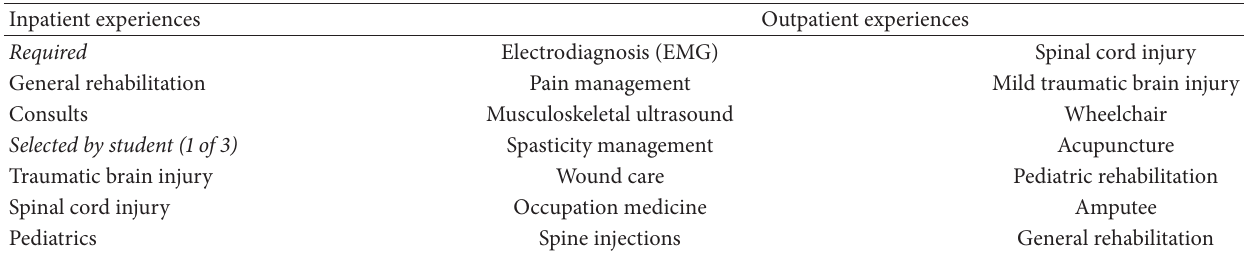
Table 1: Clinical rotations in the PM&R Clerkship